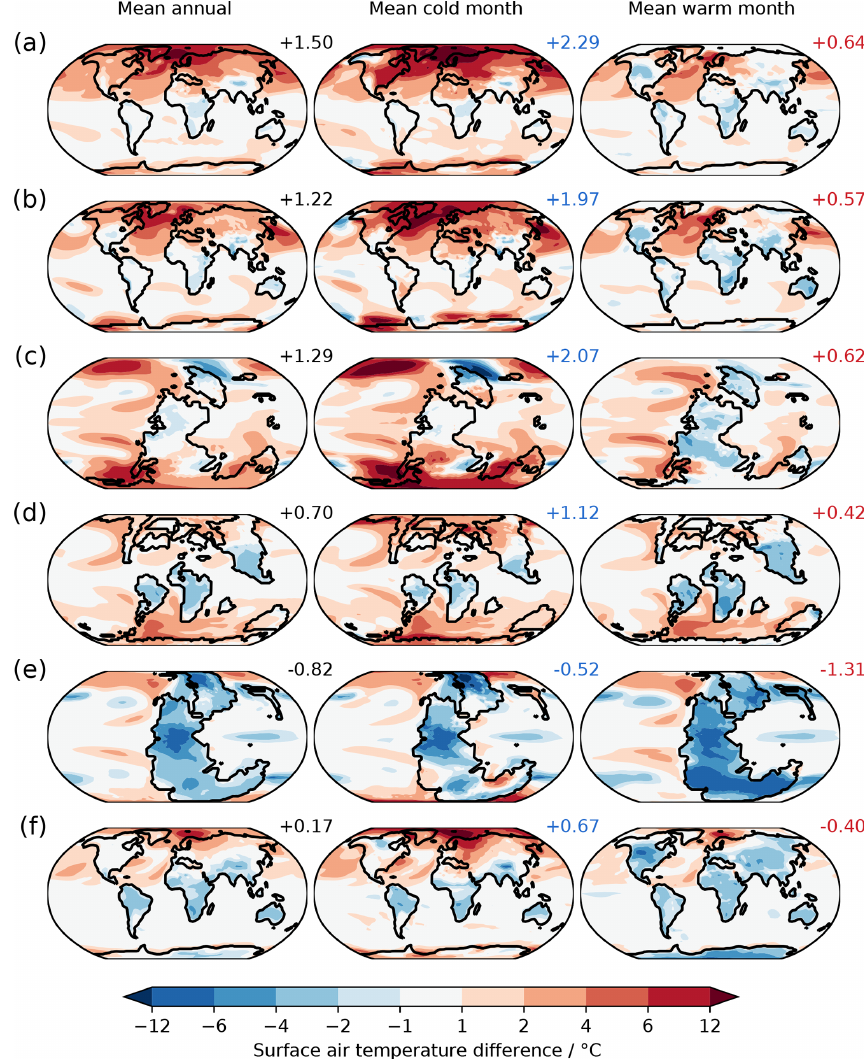
, (b) PI-CM 35 , (c) As-CM 35 , (d) Ma-CM 35 , (e) Wu-CM 35 and (f) 4 × PI-GEM 35 10 10 10 10 10 10